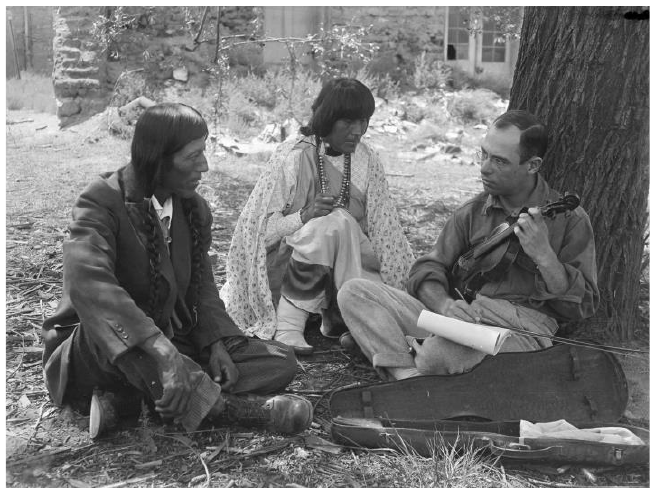
Figure 7. Photograph of Crescencio Martinez and Maximiliana Martinez, no date (before 1918). Kenneth Chapman Collection, School for Advanced Research, Santa Fe, NM,